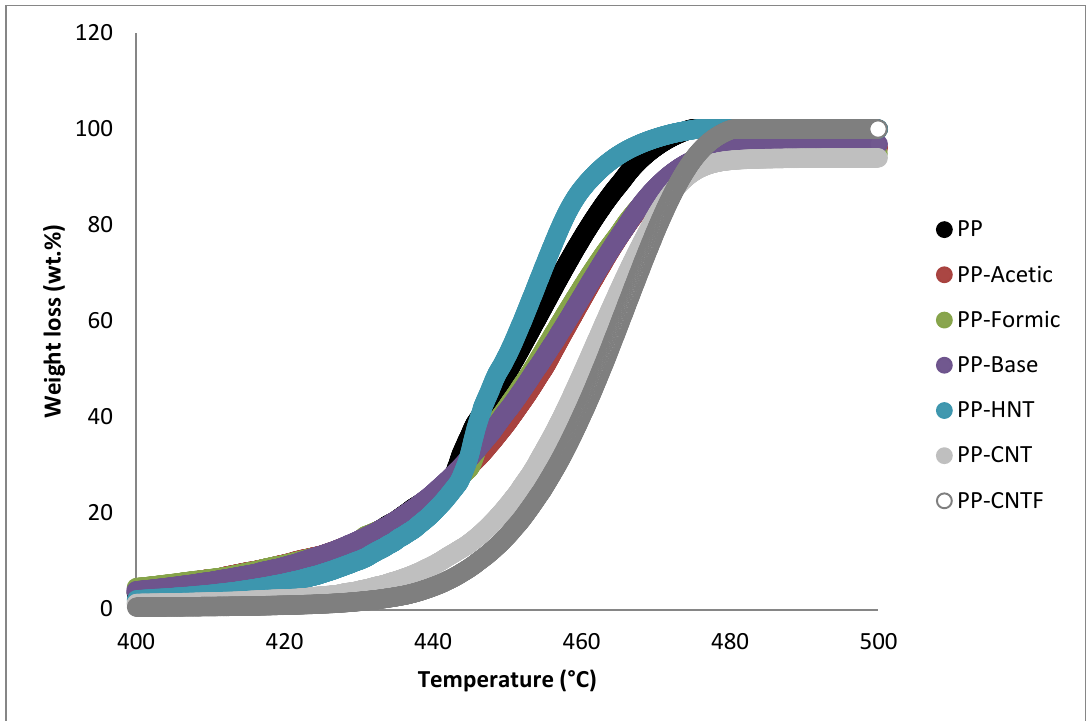
Figure 3. Temperature range from 400 °C to 500 °C where the higher weight is